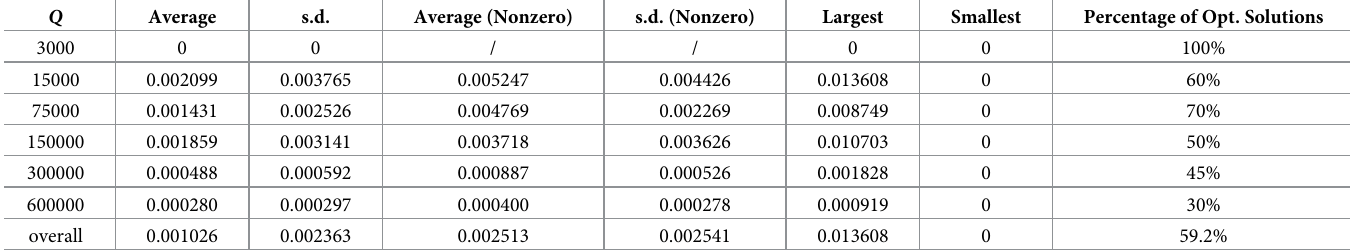
Table 13. Statistics of optimality gaps for SGDQD.